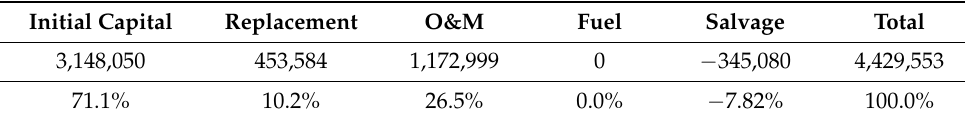
Table 14. Lifetime cost structure of topology_C by source (unit: USD).